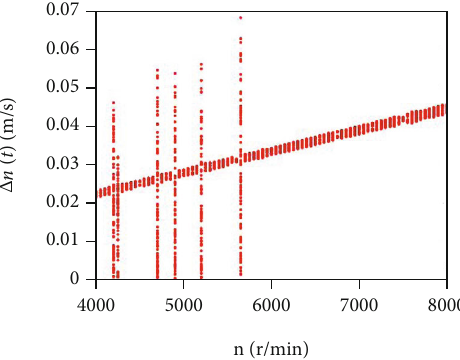
Figure 30: Bifurcation diagrams with changes in the rotation